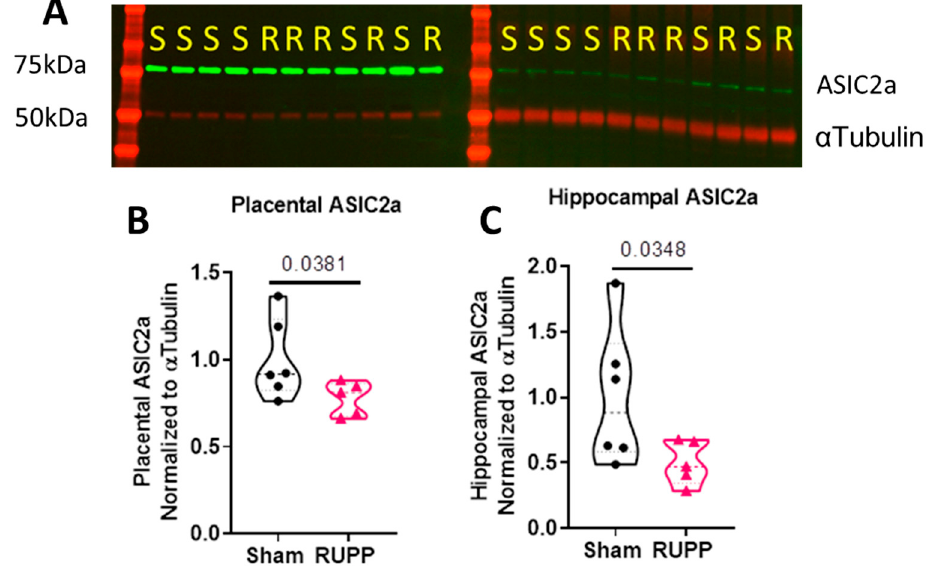
Figure 2. RUPP surgery reduces hippocampal and placental expression of ASIC2a. ( A ) Representative Western blot image from placental and hippocampal samples. Mice that underwent the RUPP procedure displayed reduced ( B ) placental and ( C ) hippocampal ASIC2a expression. Data were normalized to alpha tubulin followed by normalization to the sham levels. SHAM n = 6; RUPP n = 5. Data were analyzed using unpaired t -test ( B ) or Welch’s t -test ( C ). Points indicate values for individual dams.